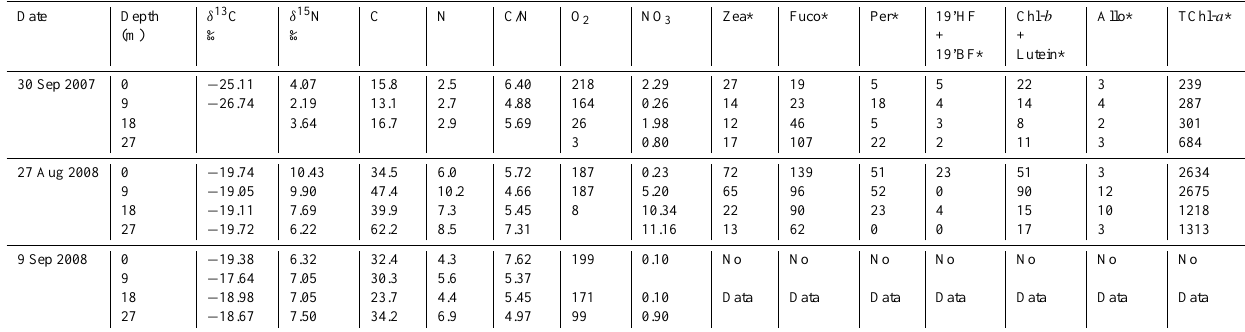
Table 2. Isotopic values ( δ 13 C and δ 15 N) of SPOM, their elemental C and N concentrations (µM), C/N ratios, O 2 , NO − pigment abundance (ngl − 1 ) during SW monsoon season at G5 station in the WCSI. (Overall mean and SD (1 σ) are not used due to significant inter-annual variability.)